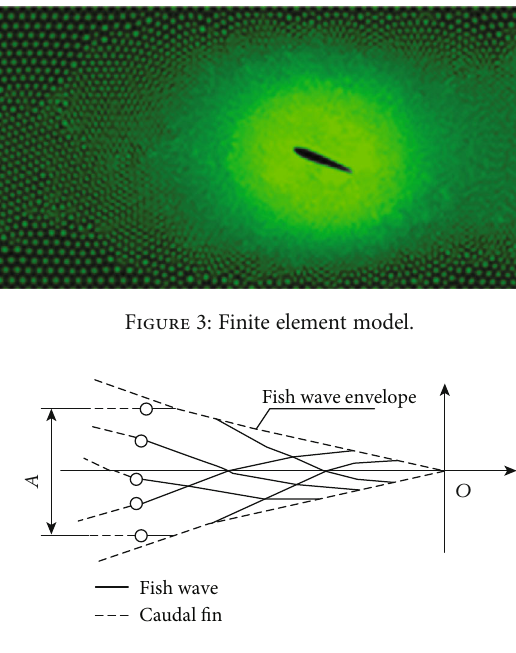
Figure 4: Fish body wave and fi sh amplitude